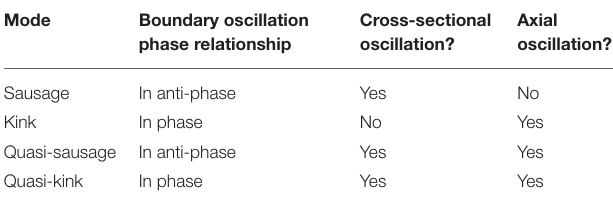
TABLE 1 | The defining characteristics of each category of